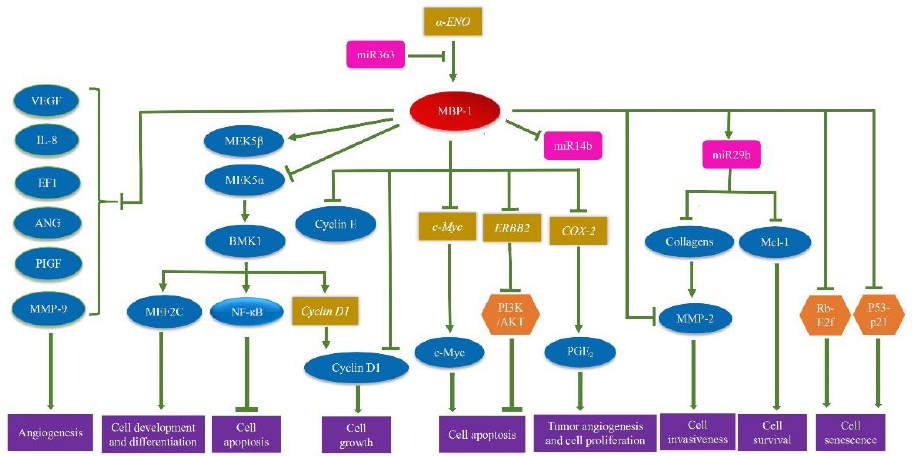
Figure 3. The regulatory network of MBP-1. Blue oval represents proteins; yellow rectangle represents genes; pink rectangle represents microRNA; orange rhombus represents signal pathway. Sharp arrow represents promotion of expression and blunt arrow represents inhibition of expression.